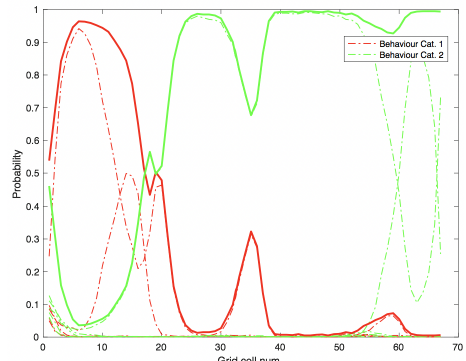
Figure 6. Evolution of beliefs, over the iterations of particle filter, on how belief for first or second category